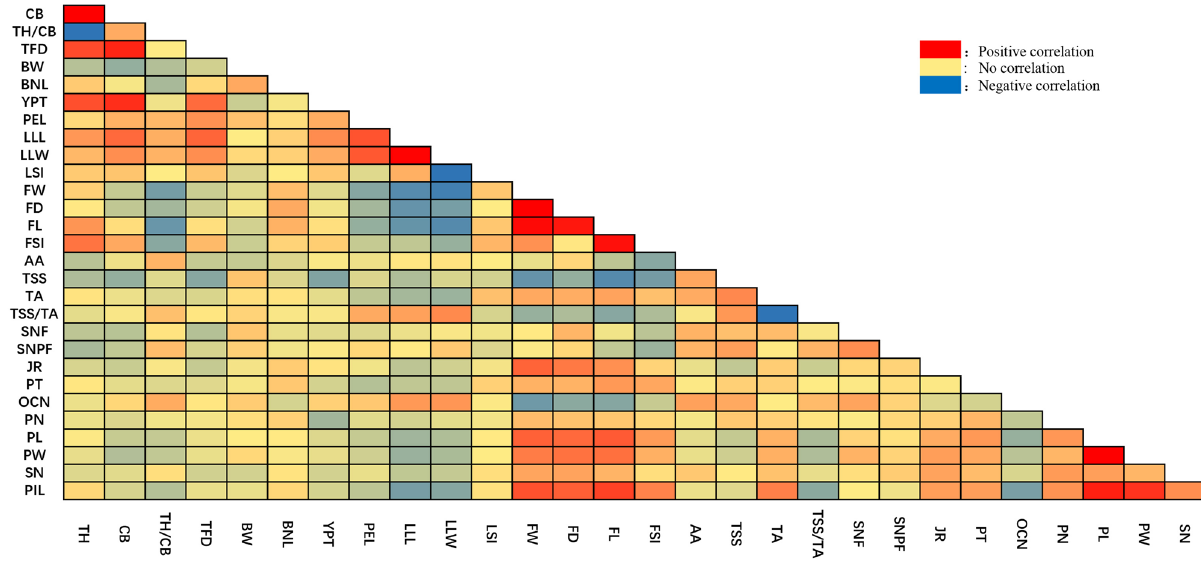
Figure 2. Correlation of quantitative traits among individuals. The blue area indicates a negative correlation between the two traits, and the red area indicates a positive correlation between the two traits. The darker the color the higher the level of correlation (figure is generated by EXCEL software, Version Microsoft Office 2020, https:// www. office.